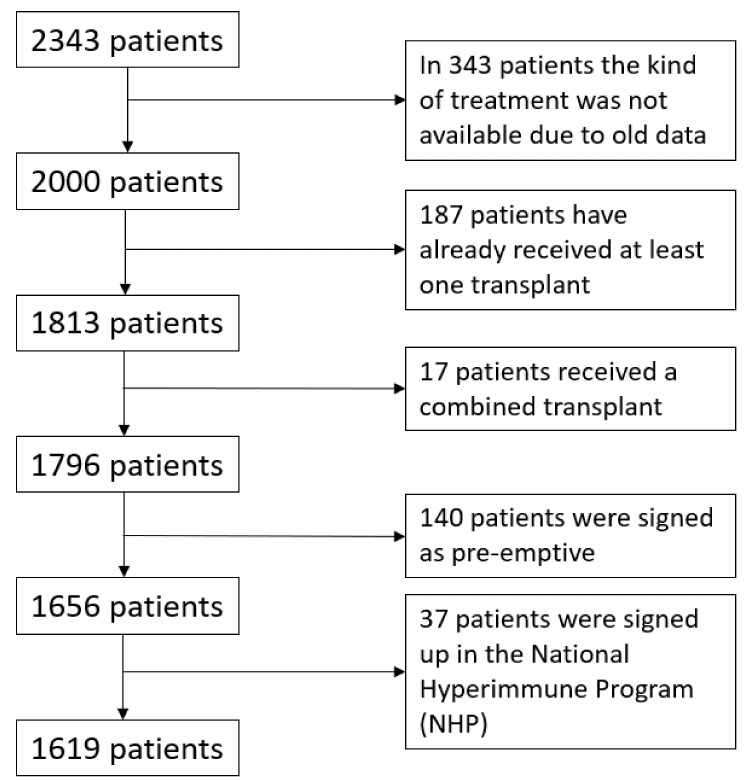
Figure 1. Patients who received a kidney transplant in Bologna Transplant Unit between 1991 and 2019 and exclusion